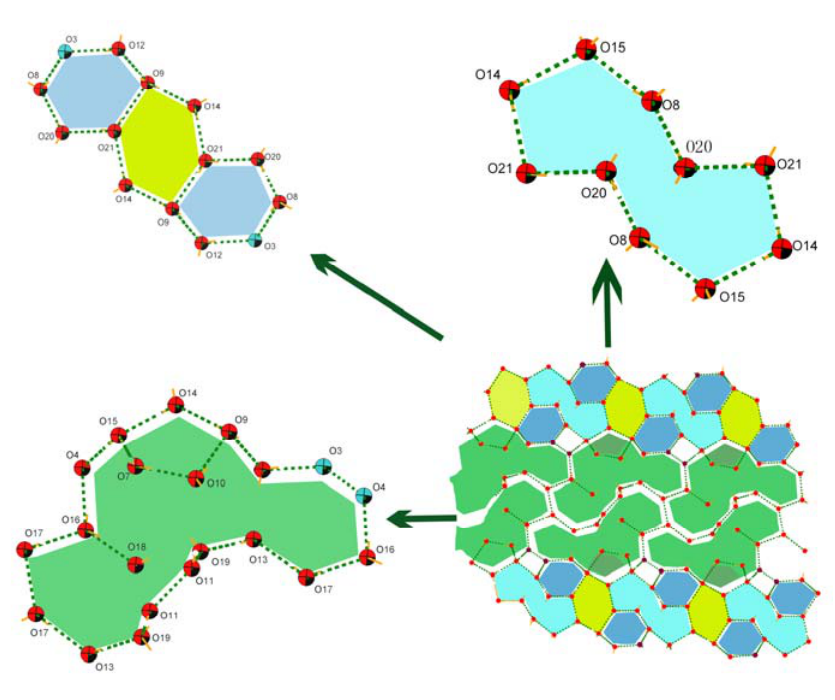
Figure 4. Perspective view of supramolecular water clusters morphology in complex 2 .